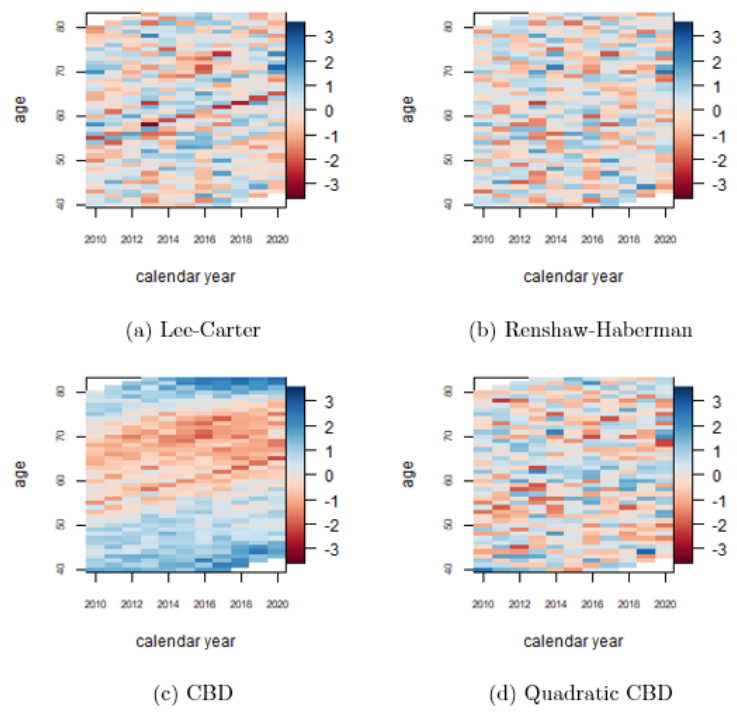
Figure 11. Heat Map of Deviance Residuals for